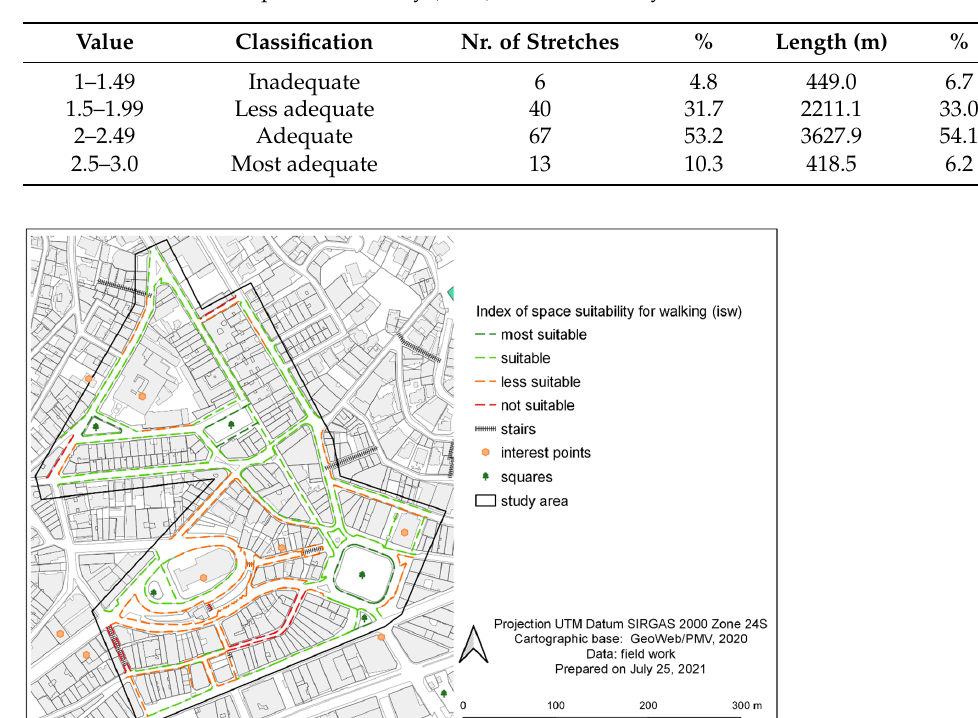
Table 12. The Index of Space Walkability (‘isw’) within the study area.